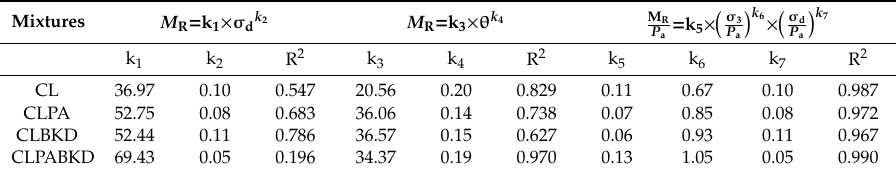
Table 9. Model constants for the optimum mixtures (Unsoaked).